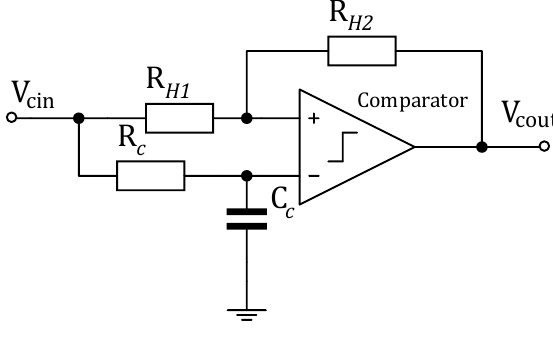
Figure 10. Analog to digital converter with adaptive